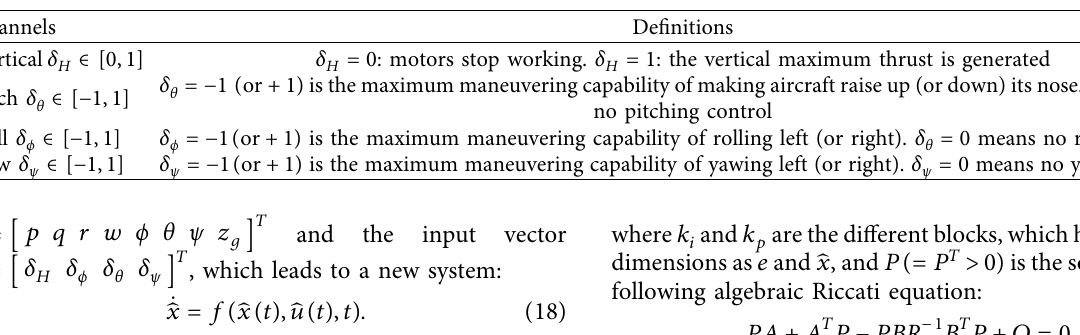
Table 2: Description of the channel